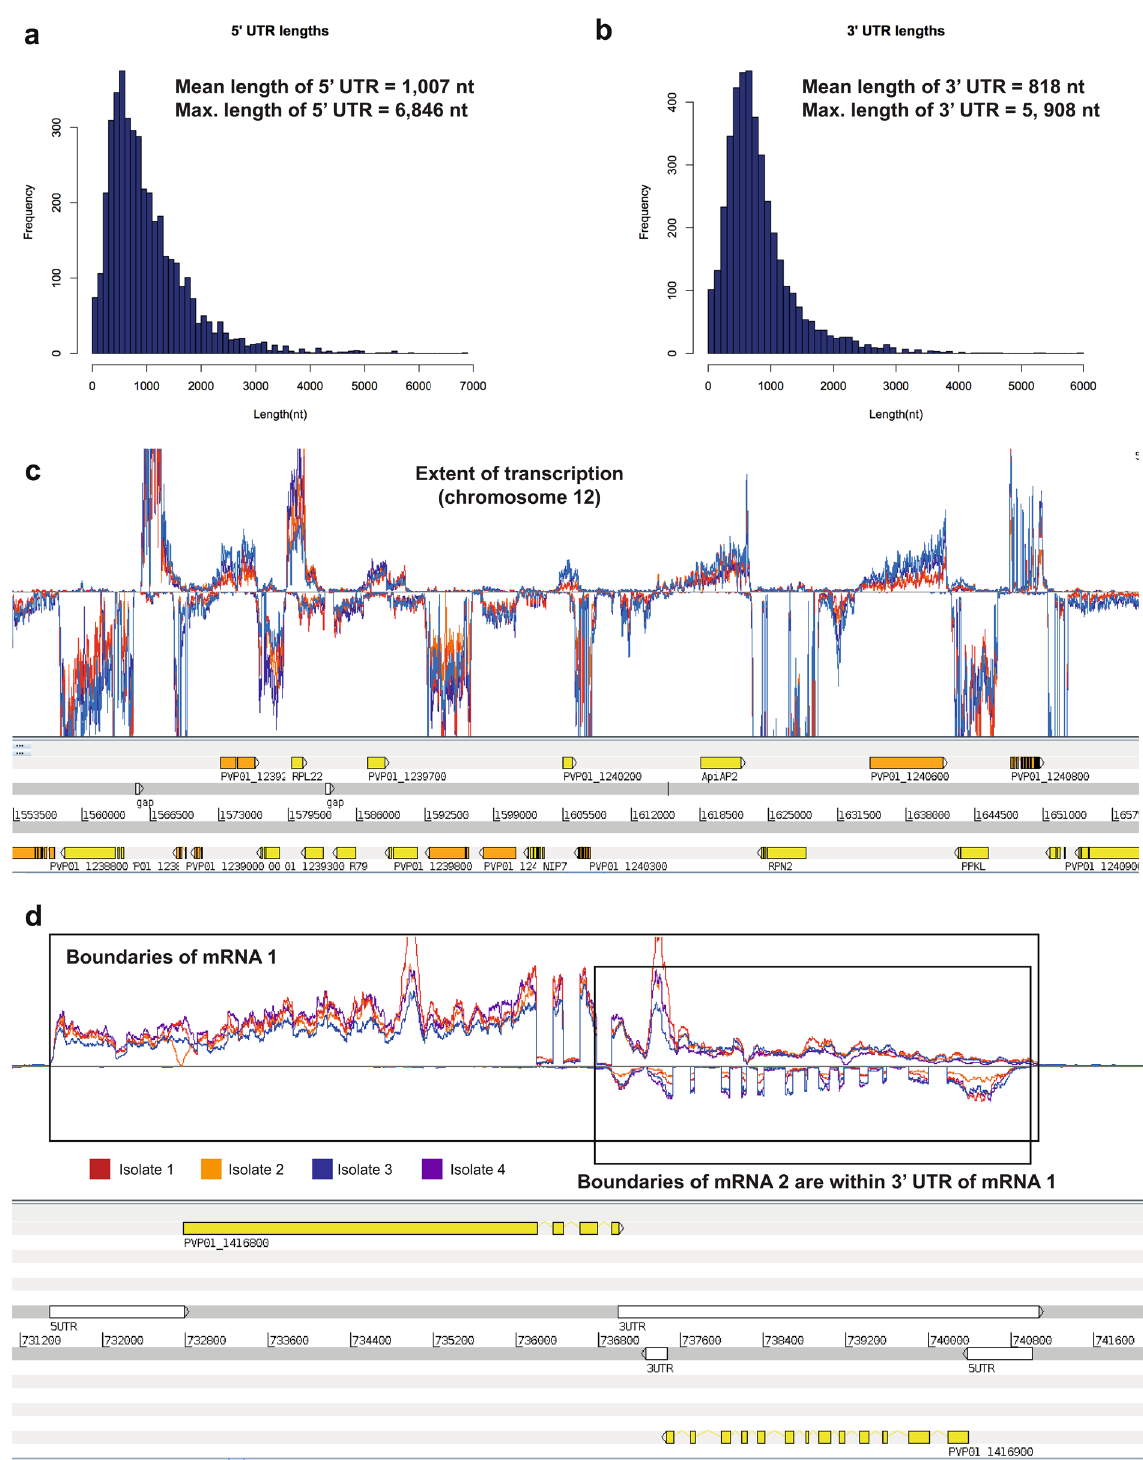
Figure 1. The extent of the P. vivax schizont transcriptome. ( a ) Size distribution of 5 ′ UTRs (n = 4155). ( b ) Size distribution of 3 ′ UTRs (n = 4091). ( c ) An overview of the extent of transcription from a representative portion of the P. vivax genome sequence (from chromosome 12). The coloured lines in the upper panel represent directional RNA-seq coverage from each of the four patient isolates, while the lower panel includes gene models on both strands of the genome sequence. ( d ) Overlapping transcripts are found even within a single life stage in P. vivax . The example shown is of a gene pair in a “tail-to-tail” orientation (PVP01_1416800 and PVP01_1416900). The boundaries of the mRNA sequence of the second gene in this pair is contained within the 3 ′ UTR sequence of the first gene in the